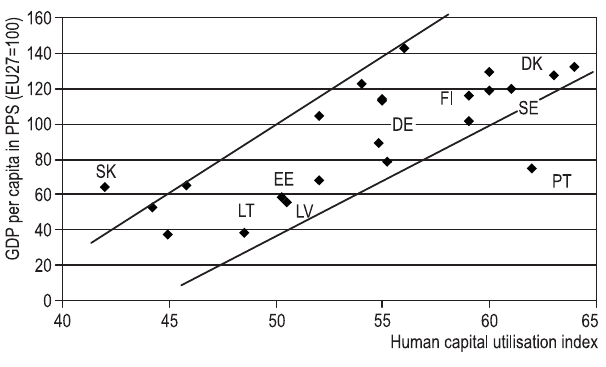
Fig. 4. Knowledge as a resource for growth